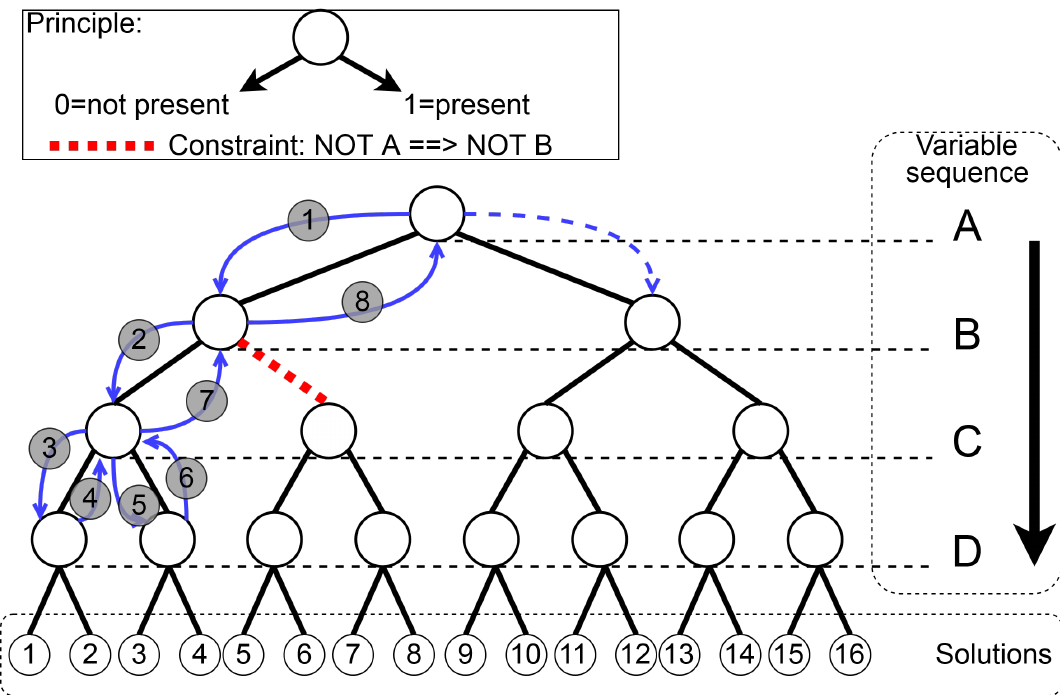
Figure 6. Illustration of the first eight steps of searching with a depth-first search and backtracking. Solutions are listed in Table